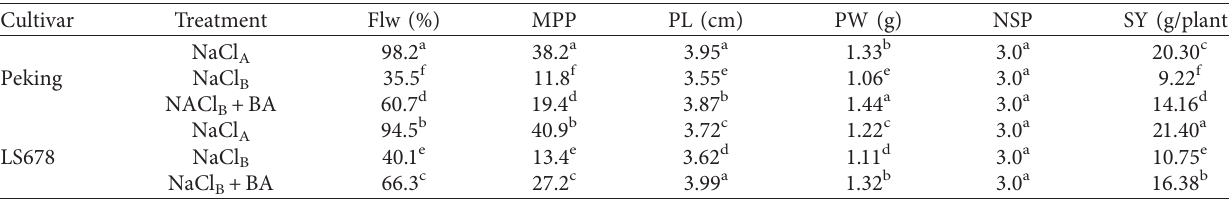
Table 2: Mean yield responses in terms of flowering (Flw), number of pods/plant (MPP), pod length (PL), pod weight (PW), number of seeds/pod (NSP), and seed yield (SY) of Peking and LS678 soybeans grown under high amount of NaCl.